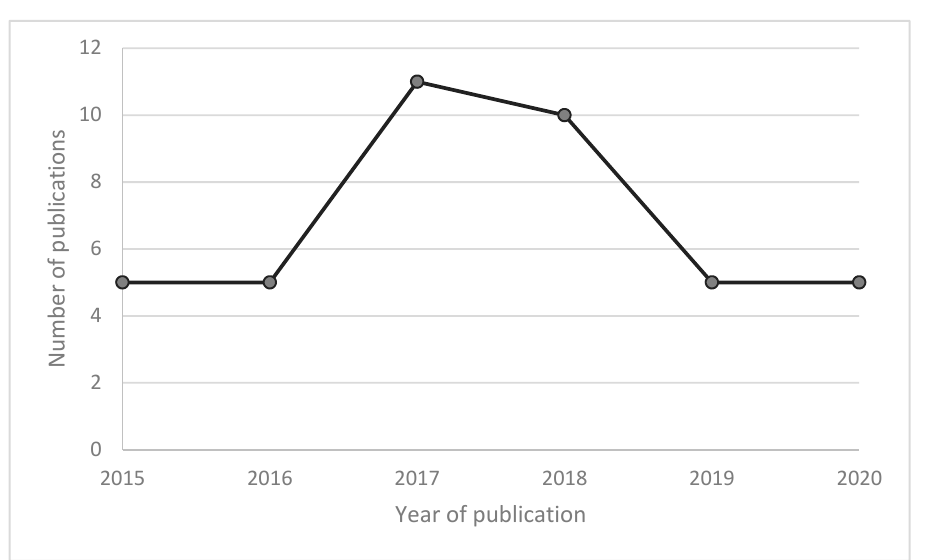
Figure 2. Number of publications from 2015 to 2020.